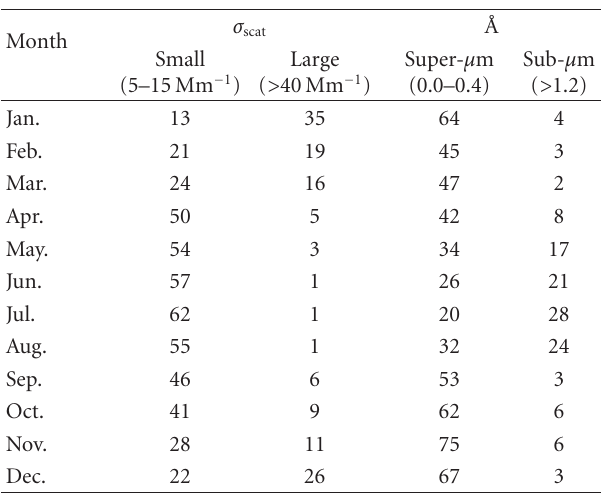
Table 1: Percentage occurrence of monthly σ scat and ˚Angstr¨om values over a period from June, 2001 to December, 2010.